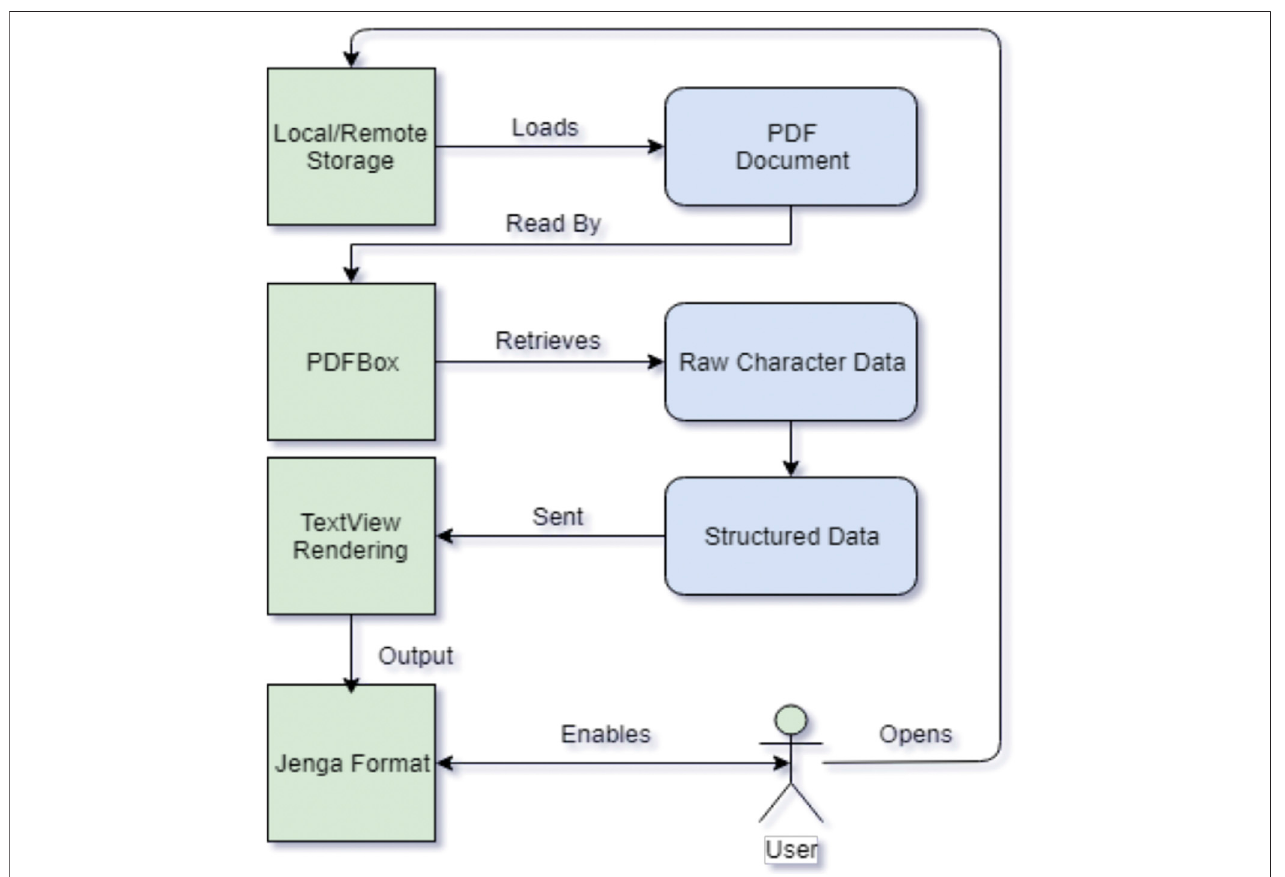
FIGURE 1 | The process of applying content transformation to a PDF